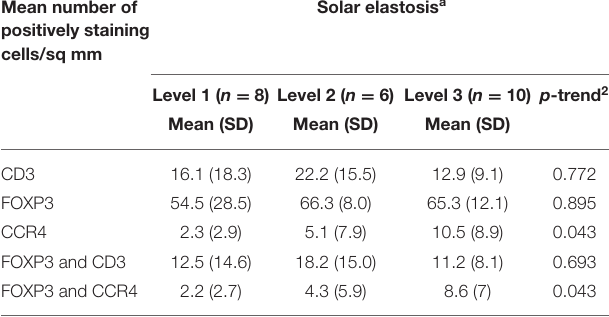
TABLE 2 | Associations between T cell subpopulations identified in incident cutaneous squamous cell carcinoma (cuSCC) and levels of solar elastosis in the normal tissue adjacent to